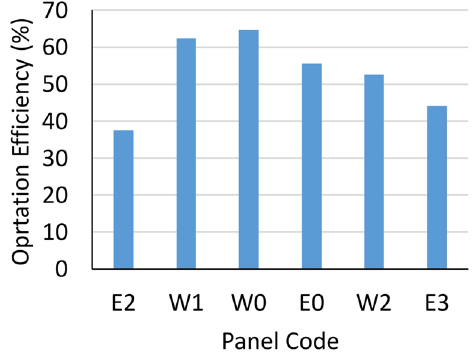
Fig. 18 Determination of operation efficiency in considered panels, in condition of removing P